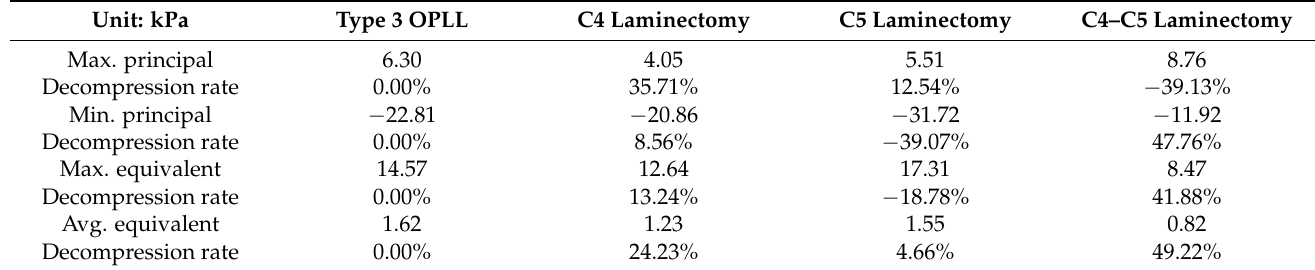
Table 12. Extension laminectomy simulation spinal cord stresses: type 3